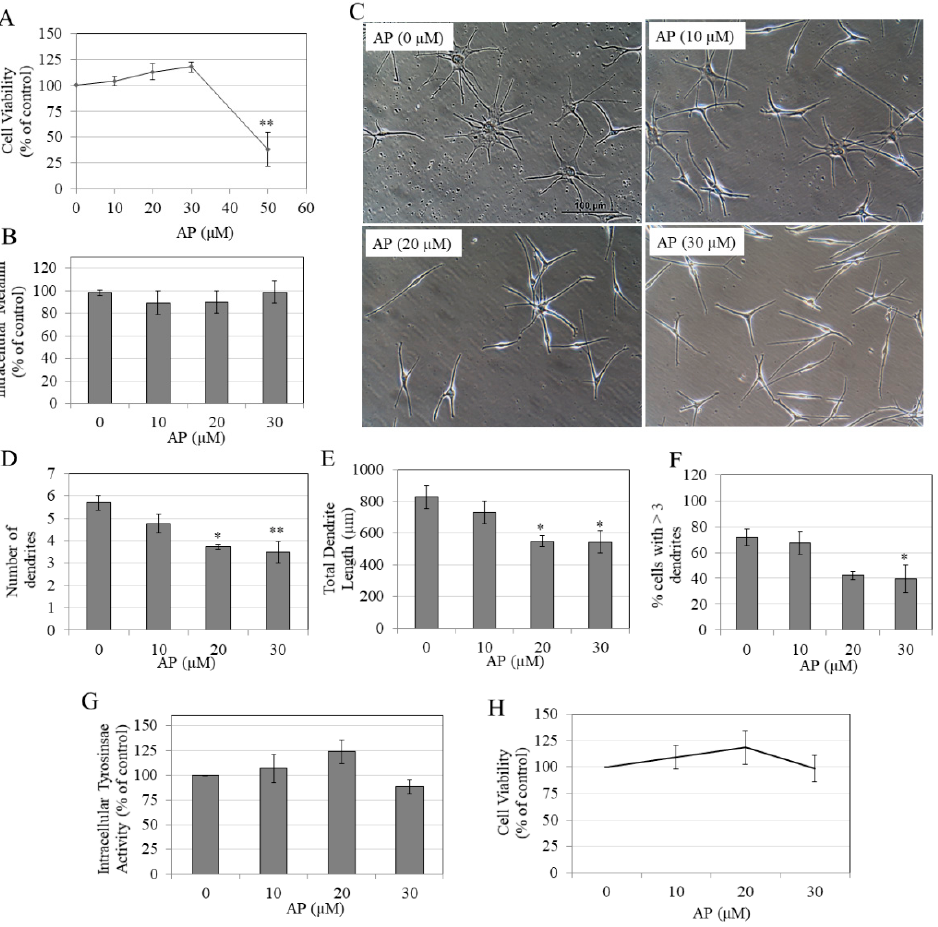
Figure 2. ( A ) Viability of HEM-DP cells treated with AP at various doses for 5 d; ** p < 0.01 vs. Control group; one ‐ way ANOVA with Dunnett’s test; ( B ) intracellular melanin levels; and ( C ) representative phase ‐ contrast images of cells treated with AP (0 – 30 μ M) taken at 20x objective magnification; melanocyte dendricity quantification by parameters: ( D ) Number of dendrites, ( E ) total dendrite length, and ( F ) % cells with >3 dendrites; a total of ~100 cells were counted for each treatment group; * p < 0.05 and ** p < 0.01 by one ‐ way ANOVA with Dunnett’s test; ( G ) Intracellular tyrosinase activity in cultures of HEMn ‐ DP cells treated with AP for 5 d; ( H ) viability of human keratinocytes (HaCaT) treated with AP at various doses for 5 d. All data are mean ± SEM of at least three independent experiments.